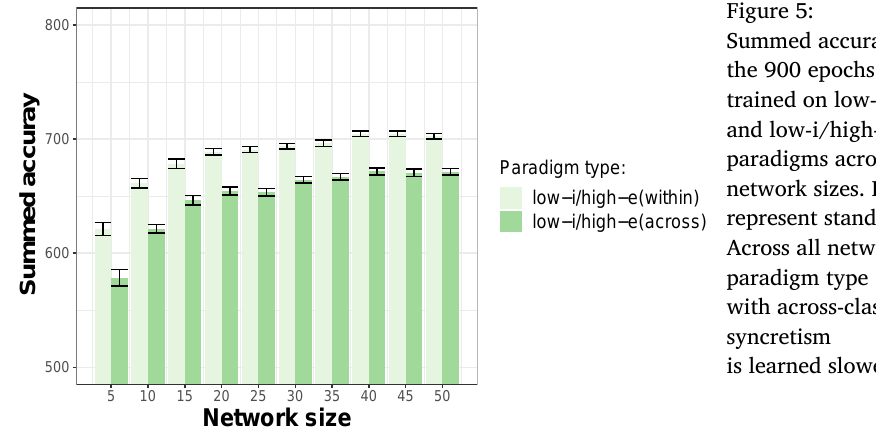
Paradigm type: low−i/high−e(within) low−i/high−e(across)